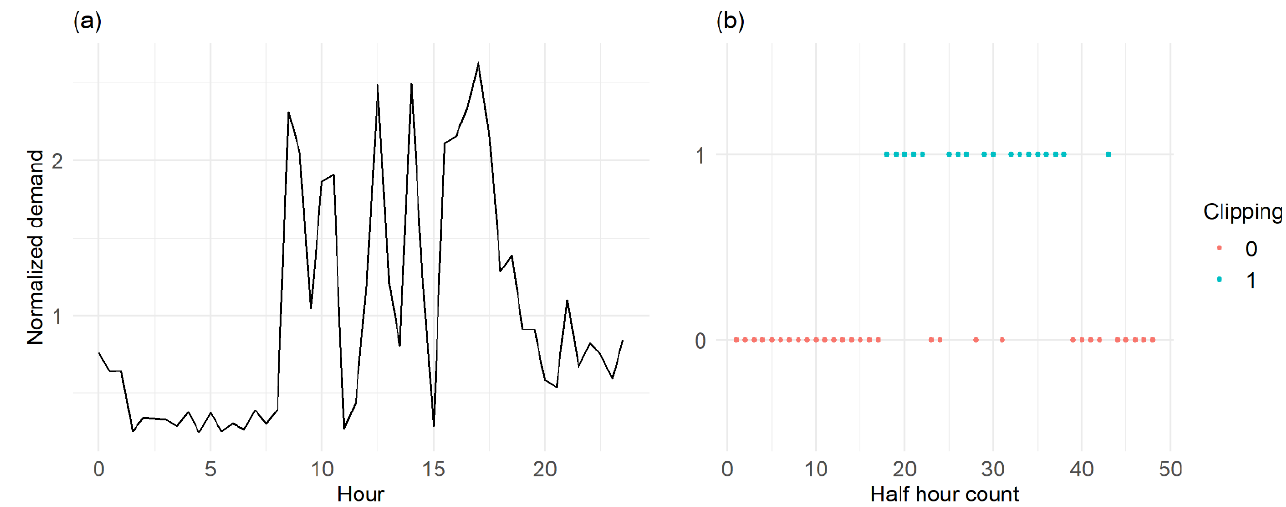
Figure 7. Application of clipping time series representation of a typical day of normalized demand. ( a ) Original mean daily normalized half-hourly demand for customer ID 1260 for 1 January 2010. ( b ) Clipping representation of the load curve for that day.